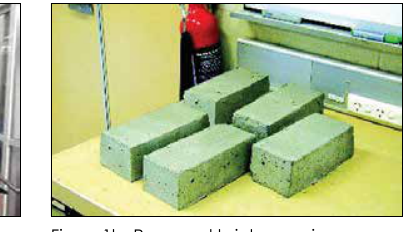
Figure 1a: Hydraulic press machine Figure1b: Prepared bricks